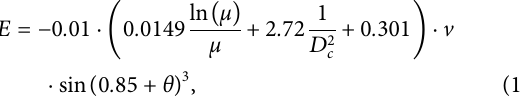
Frontiers in Earth Science |